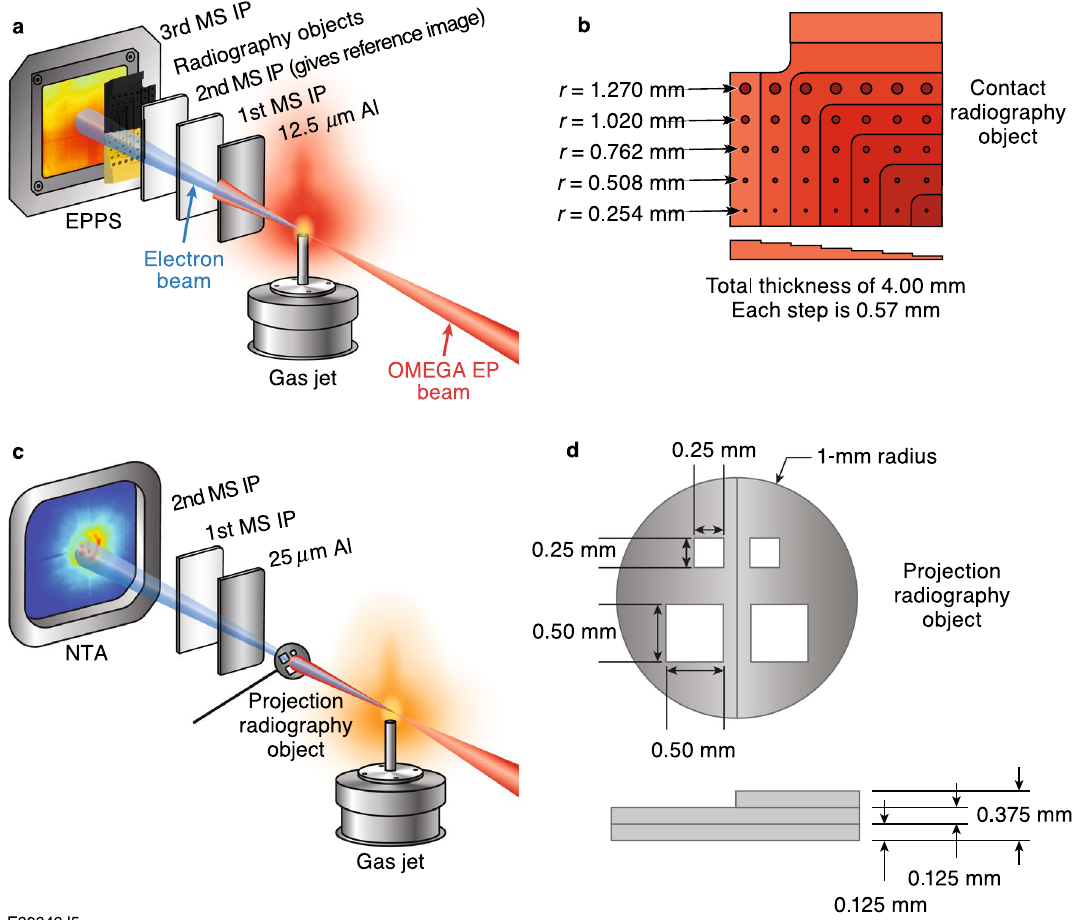
Figure 3. ( a ) Experimental setup for contact LPA eRad using radiography test objects, ( b ) placed directly onto image plates and ( c ) projection LPA eRad using 2-mm-diam radiography test objects, ( d ) offset from the image plates by distances ranging from 3.58 to 33.58 cm.